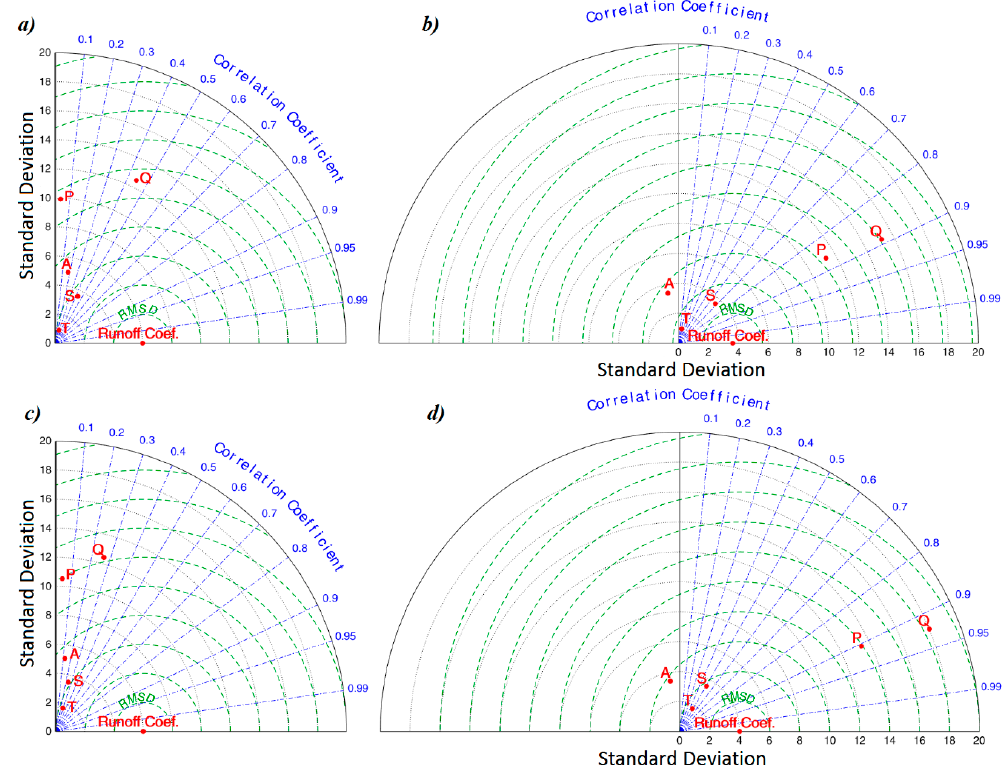
Figure 9. Taylor diagrams between the total runoff coefficient and temperature (T), precipitation (P), actual evapotranspiration (A) and soil water volume (S) during the dry (left) and wet (right) seasons in RCP 4.5 (( a ) and ( b )) and RCP 8.5 (( c ) and ( d )).